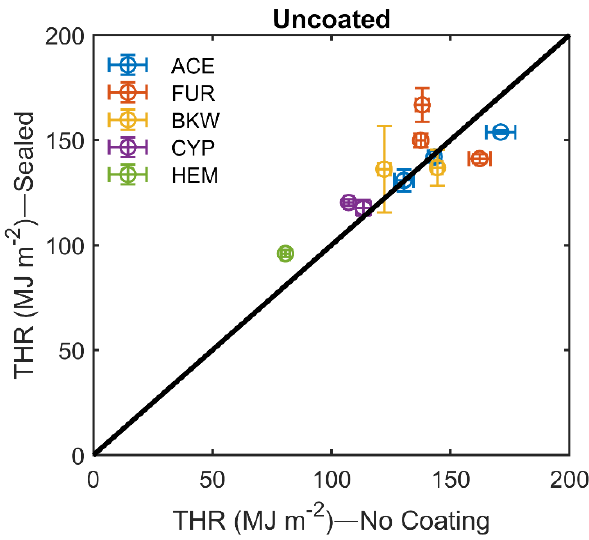
Figure 9. Comparison of the total heat released (THR) between the sealed and uncoated specimens.